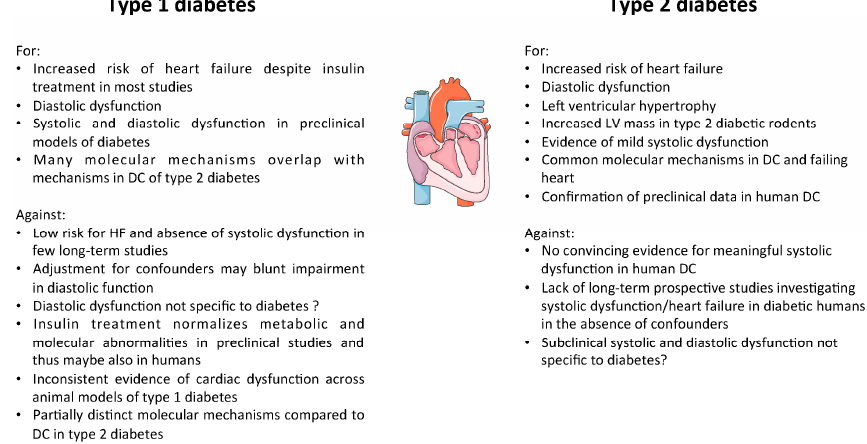
Figure 1. A compilation of arguments for and against the existence of diabetic cardiomyopathy in type 1 and type 2 diabetes. HF, heart failure; DC, diabetic cardiomyopathy; LV, left ventricular.